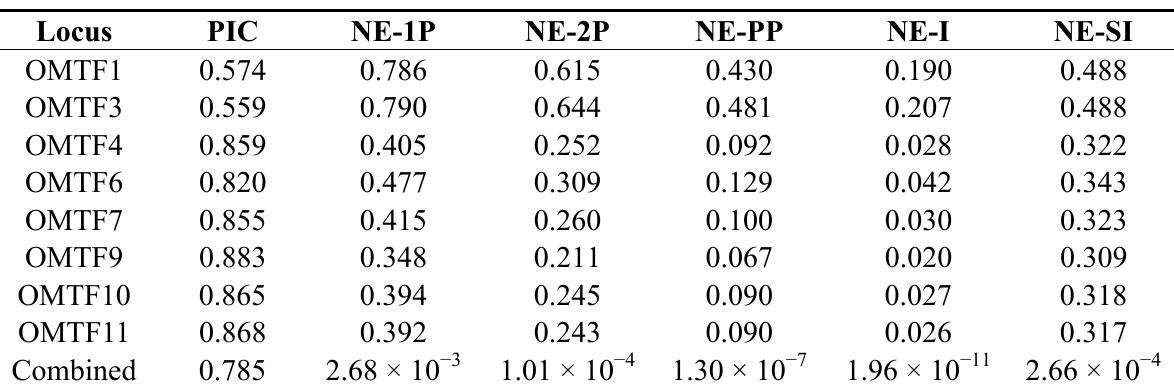
Table 2. The values of polymorphism information content (PIC) and non-exclusion probability (NE) of paternity and identity for the eight microsatellite loci in the Omei treefrog ( Rhacophorus omeimontis ). NE-1P, NE of first parent; NE-2P, NE of second parent; NE-PP, NE of parent pair; NE-I, NE of identity; NE-SI, NE of sib